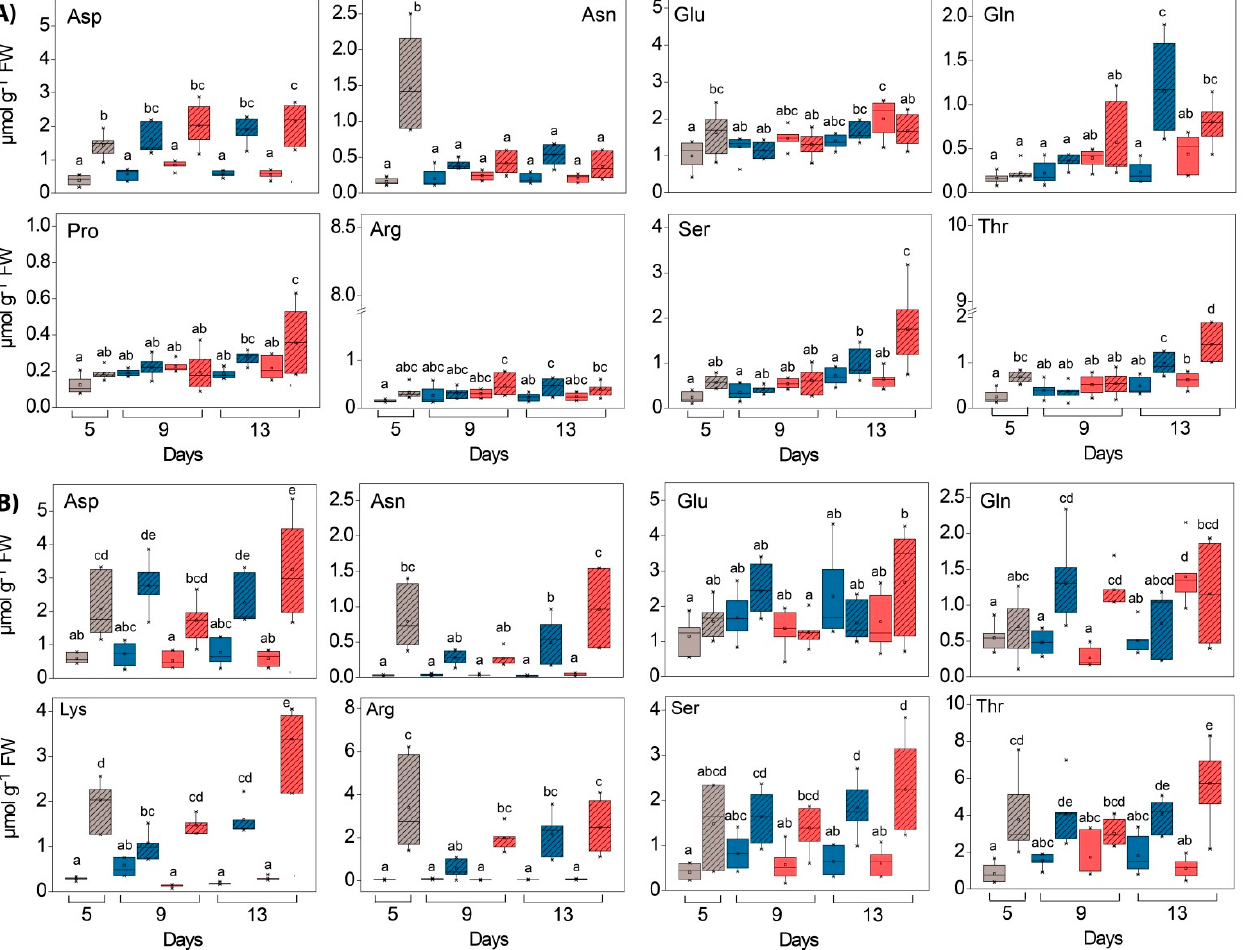
Figure 12. Content of polar free amino acids (Asp, Asn, Glu, Gln, Pro/Lys, Arg, Ser, Thr) in GL (solid boxes) and WL (striped boxes) of P. zonale plants prior to (5 d, grey) and after four (9 d) and eight days (13 d) of exposure to high light (HL, 800 µmol m –2 s –1 , red) compared to those exposed to low light (LL, 180 µmol m –2 s –1 , blue) under ( A ) optimal (25 °C, HL ) and ( B ) lower (18 °C, Cold + HL ) temperatures. Values are shown in µmol g –1 FW ± SE, n = 6–8. Different letters indicate statistically significant differences between different PAR intensities, time points, and leaf tissues ( p < 0.05) according to Tukey’s post hoc test.